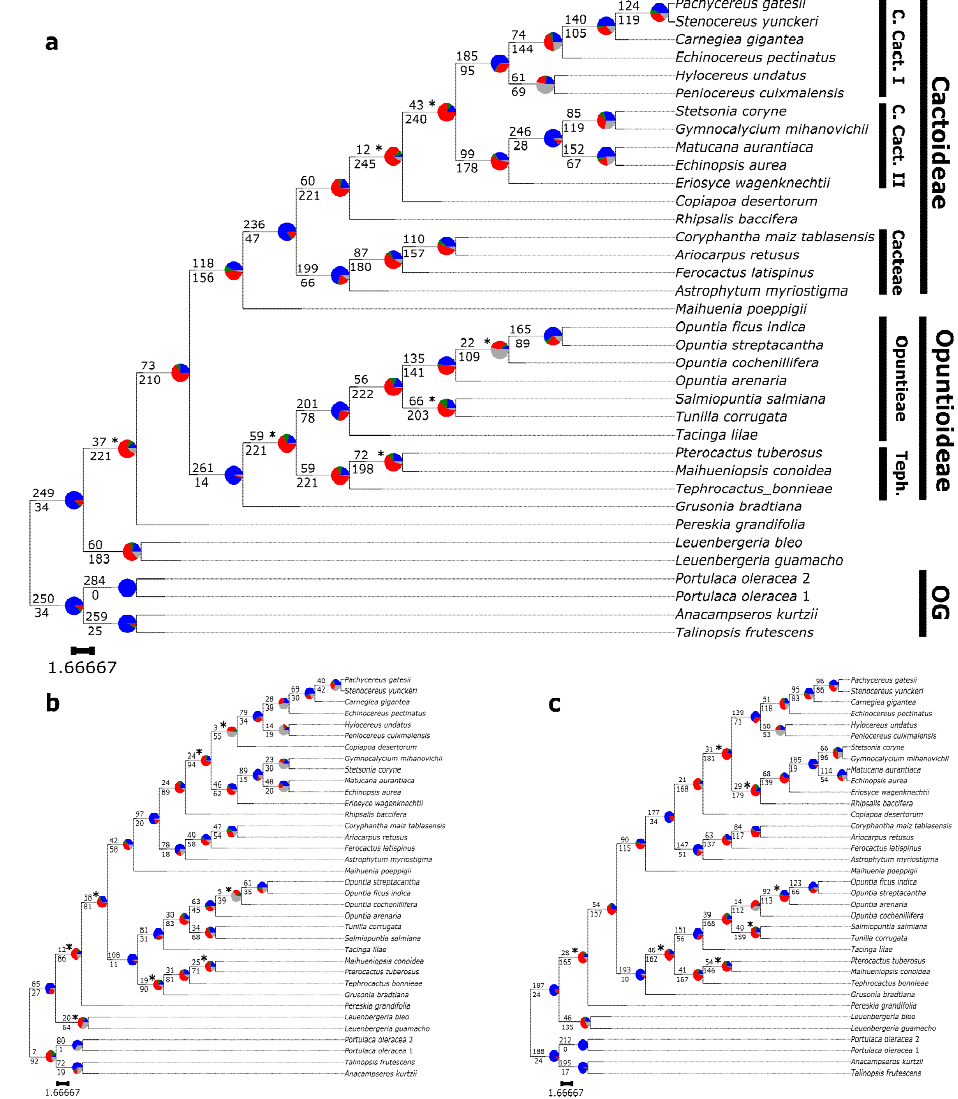
Figure 4. ASTRAL species tree with pie charts on the nodes representing gene tree topology proportions: blue represents concordance with the shown topology, green is the top alternative bipartition; red is all the other alternative bipartitions; and grey is no support for conflicting bipartition. Branch values represent concordance (top) and conflicting (bottom) gene trees. Asterisks mark all nodes with a posterior probability of ≤90 and scale bars represent coalescent units. ( a ) C120 and A353 probe sets combined. OG: Outgroups; Teph.: Tephrocacteae; C. Cact.: Core Cactoideae. ( b ) C120 probe set. ( c ) A353 probe set.